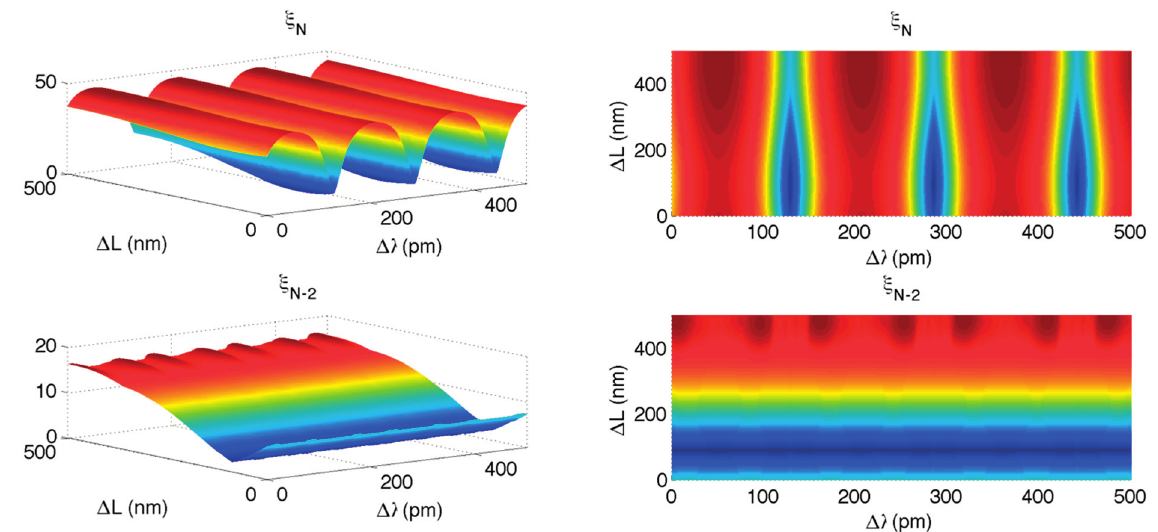
Figure 12. KLT applied to long-range interrogation of FBG/FPI. The upper charts shows the high-rank eigenvalue ξ N as a function of FBG wavelength shift Δλ and FPI cavity length expansion Δ L; the lower charts show the eigenvalue ξ N − 2 as a function of Δλ and Δ L. Left charts plot the full 3D view; right charts show the 2D